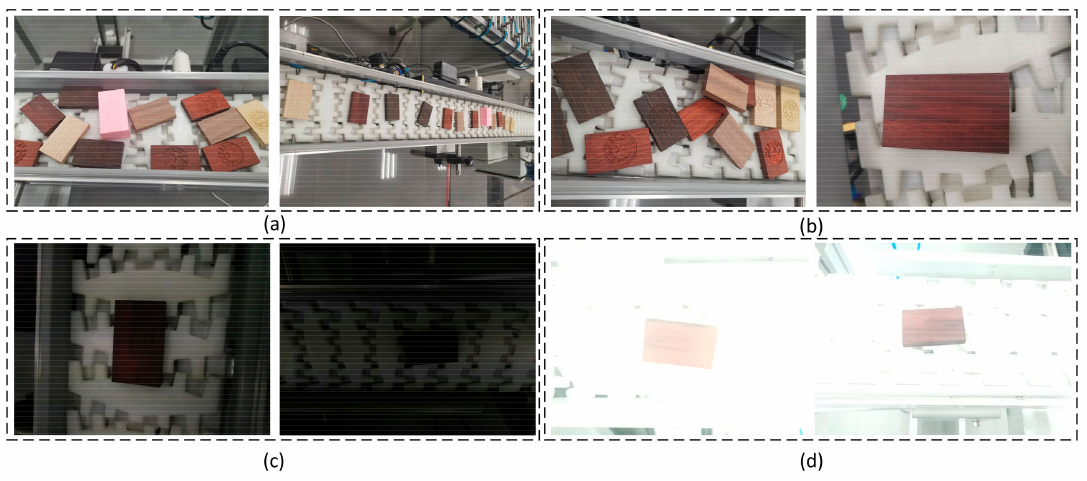
Figure 2. Target training images under different environmental conditions. The picture contains ( a ) different interference backgrounds, ( b ) different visual field distances, ( c , d ) are different light